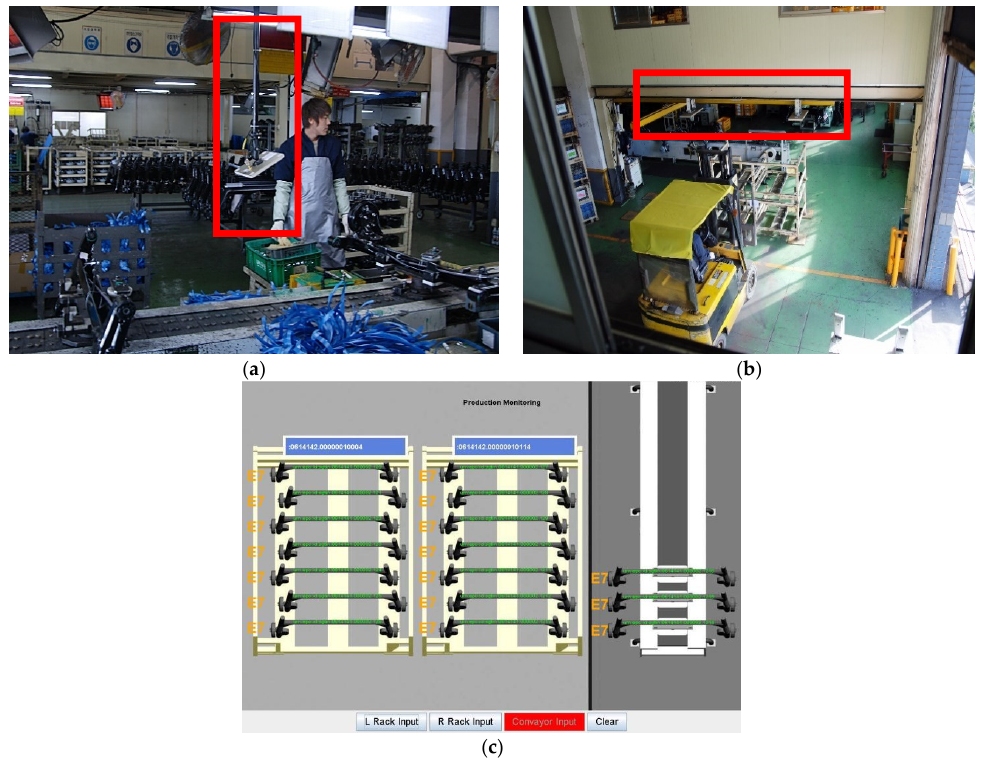
Figure 5. Production monitoring in the supplier plant. ( a ) Read point at production line; ( b ) Read point at 7 ‐ rack loading area; ( c ) Screen shot of production monitoring application.